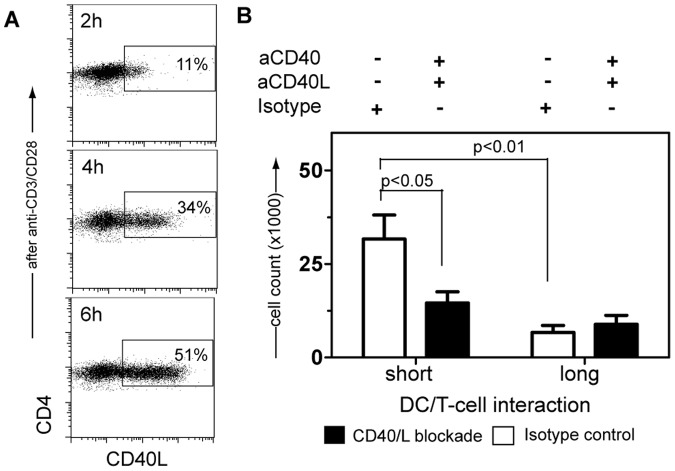
Blockade of CD40/CD40L signaling in short- versus long-term DC/T-cell Co-cultures.(A) CD40L expression on CD4+ T-cells activated after 2, 4 and 6 hours of CD3/CD28 cross-linking is shown. One representative out of 4 experiments is depicted. (B) Short- or long-term co-culture of CD3+ T-cells and DCs, activated with LPS/IFN-γ for 6 hours, in the presence of blocking CD40 and CD40L monoclonal antibodies (black bars) or isotype control immunoglobulins (white bars) is shown. Median±SEM of 7 to 12 experiments is depicted. DCs from Donors A, B and D were used in experiments (A) and (B).